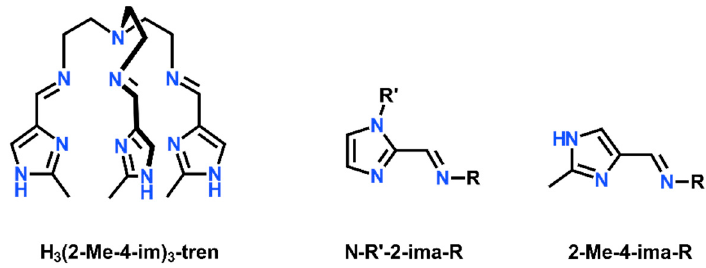
Chart 1. Structure of the common ligands used in mononuclear imidazole SCO systems. SCO systems with chelating imidazole ligands are also well described with [Fe(2-Me-4-ima-